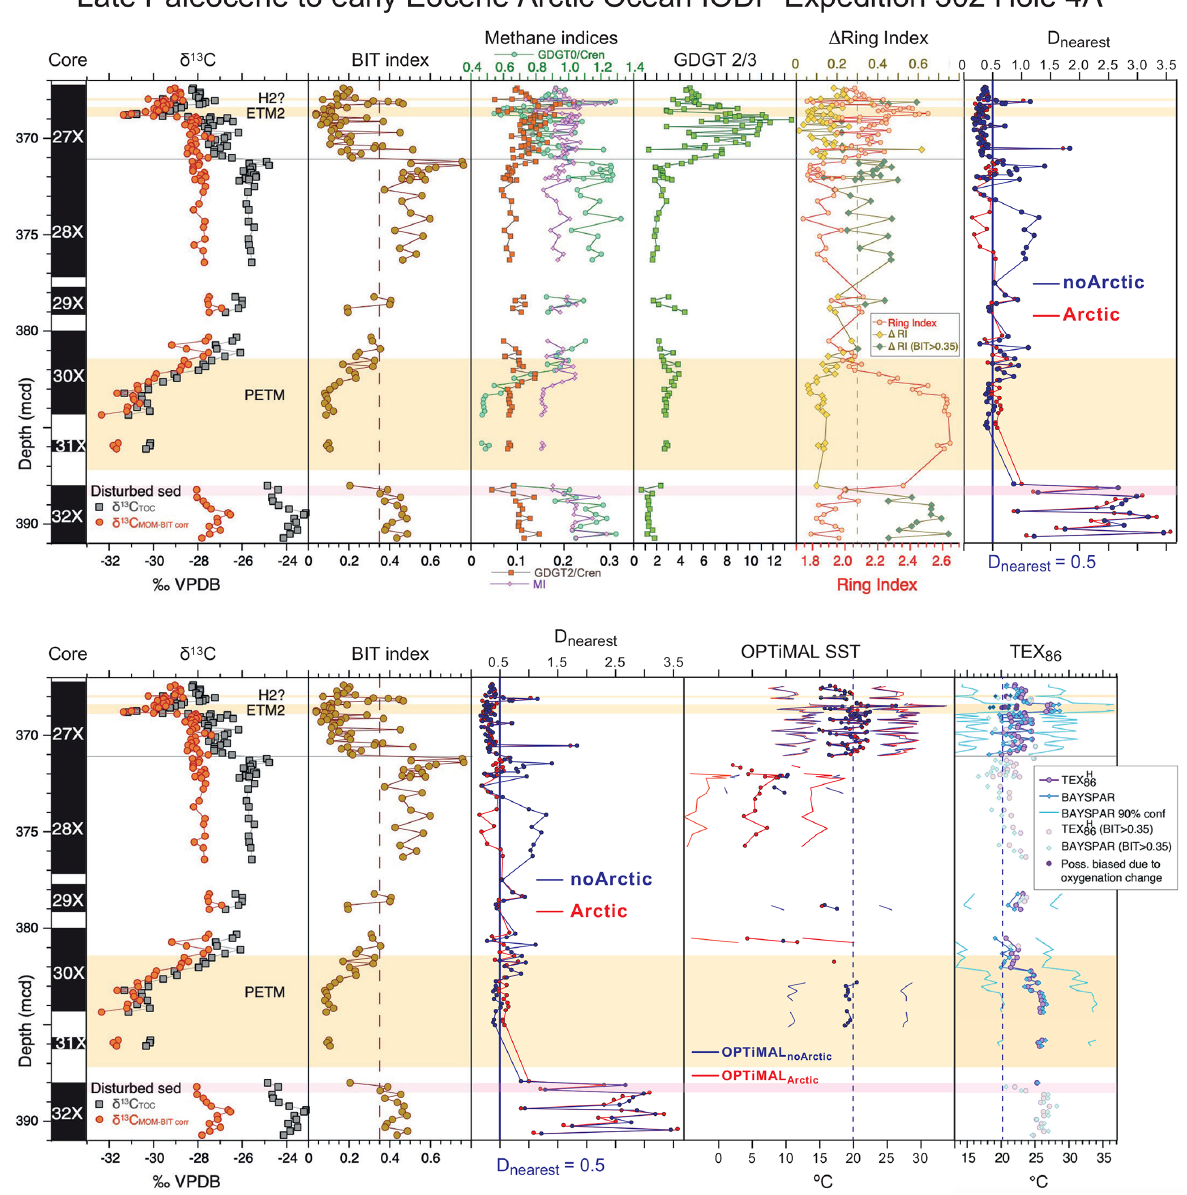
, BAYSPAR and OPTiMAL SSTs from the Arctic Site IODP Expedition 302 Figure 17. Comparison of GDGT screening indices, TEX H 86 Hole 4A. Depths are metres composite depth (mcd). Data and figures modified from the most recent reassessment by Sluijs et al.